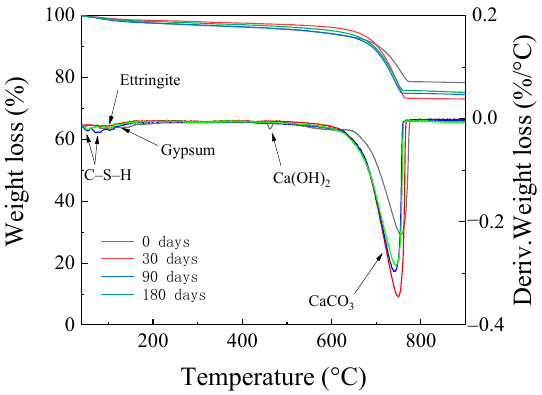
Figure 10. Thermogravimetric (TG) analysis of the HBPRC.